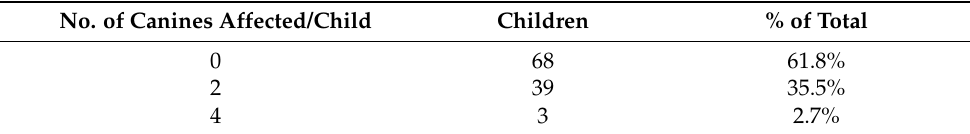
Table 3. Frequencies of the number of temporary canines affected for every child.